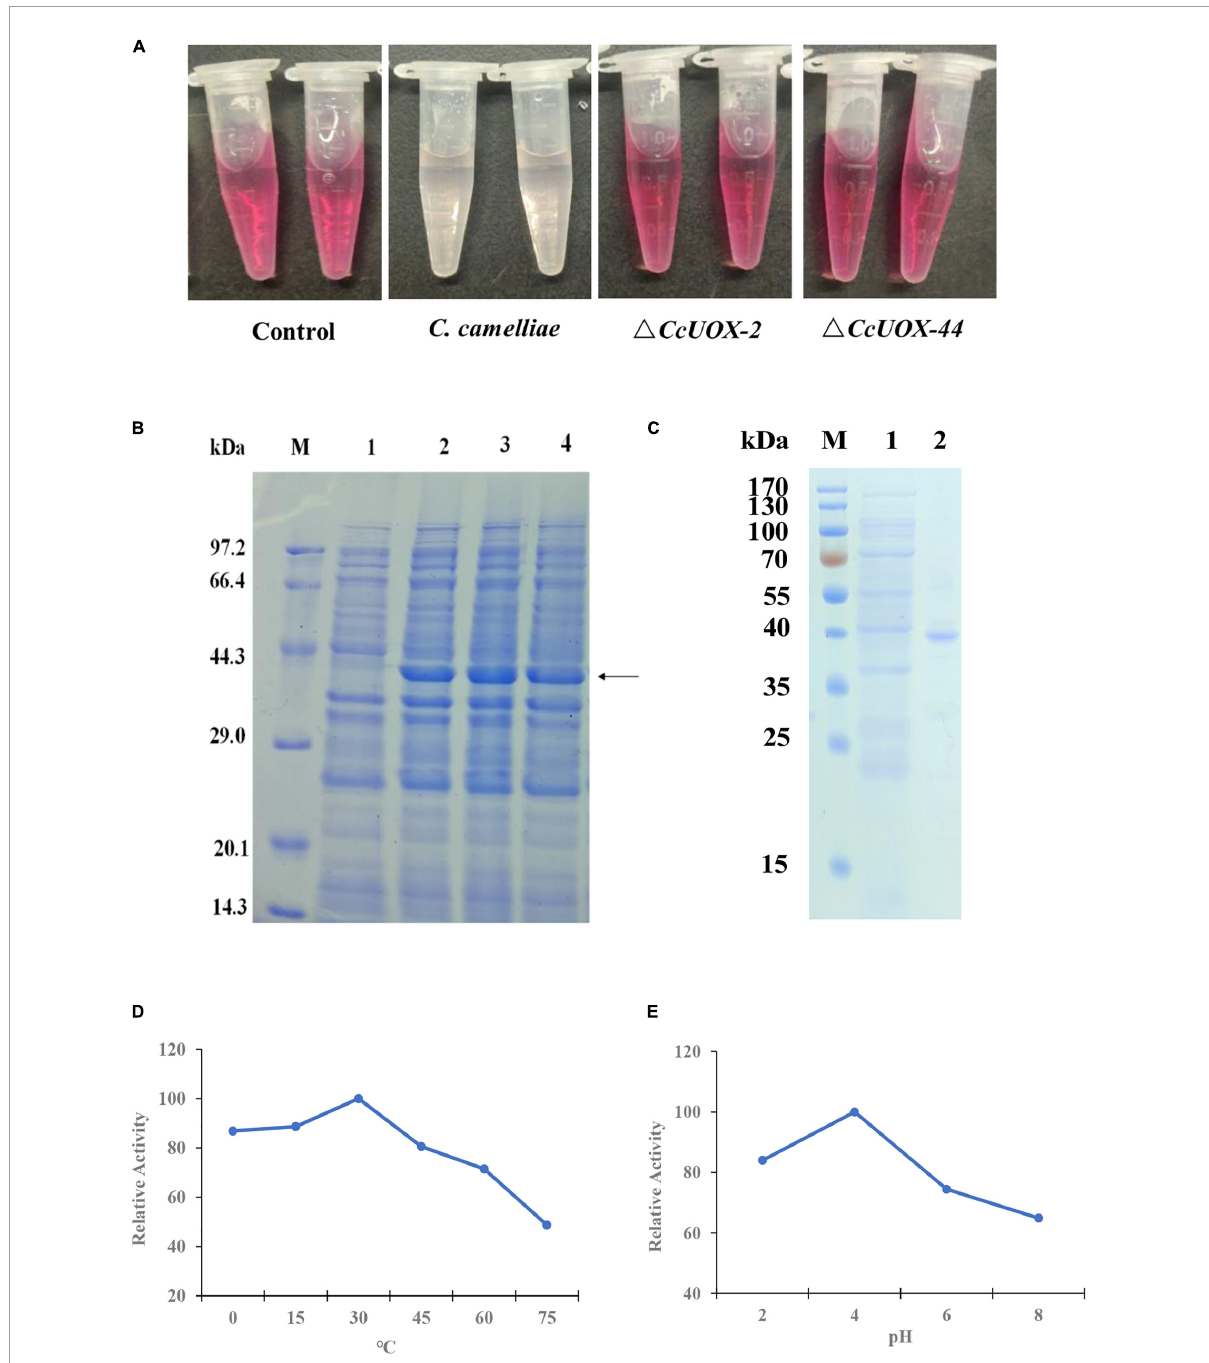
FIGURE7 CcUOX involved in uric acid degradation both in vivo and in vitro . (A) C. camelliae CcUOX involved in uric acid degradation in vivo . In the control sample, no fungi were added and the uric acid was not degraded at all. In the C. camelliae wild-type strain CCA added sample, the uric acid was almost lost as the color was clear. In the (cid:49) CcUOX mutants incubated samples, the uric acid was not degraded as the color was not changed since the deletion of CcUOX . (B) SDS-PAGE analysis of recombinant CcUOX in Escherichia coli . The proteins were stained with Coomassie brilliant blue R-250. M, Position of marker proteins. Line 1, SDS-PAGE of the extract from empty pET28a-transformed bacterial cultures (control). Line 2–4, SDS-PAGE of the recombinant CcUOX protein which was induced from pET28a-CcUOX-transformed different bacterial cultures. The arrow indicates the recombinant CcUOX protein. (C) SDS-PAGE of the recombinant CcUOX protein. M, Position of marker proteins. Line 1, SDS-PAGE of the extract from control bacterial culture. Line 2, the partly purified CcUOX protein. (D,E) The optimum temperature (D) and pH (E) for recombinant CcUOX protein in catalyzing uric acid in vitro . The highest activity was considered as 100% and all the experiments were replicated thrice with similar